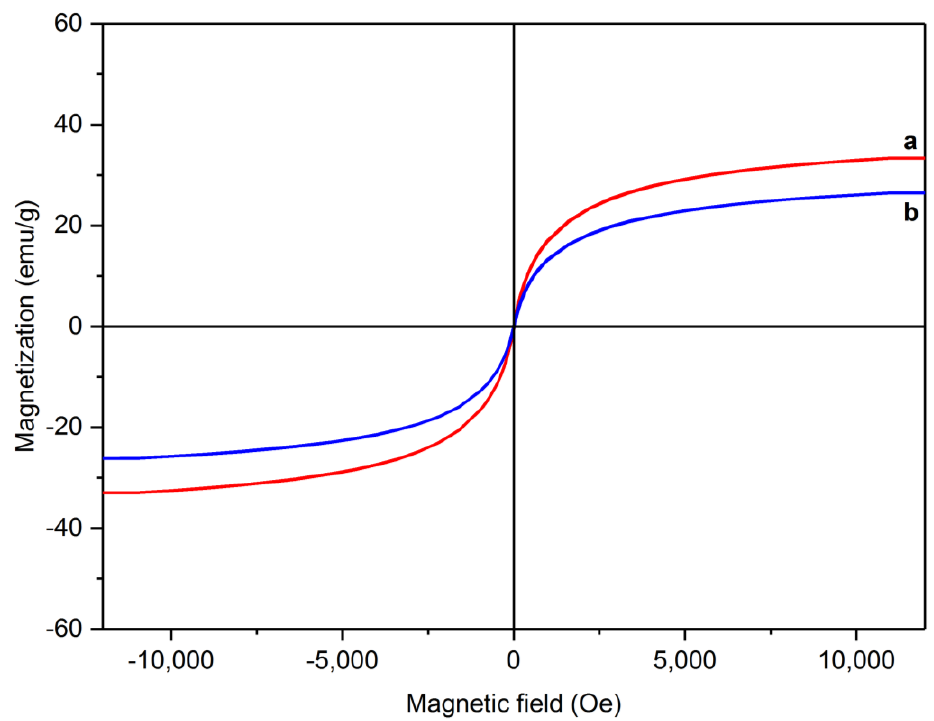
Figure 6. Magnetic hysteresis loops for RMNPs (a) and DextCHO-RMNPs